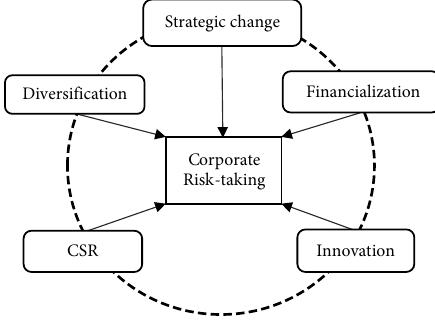
Figure 1. Framework conceptual